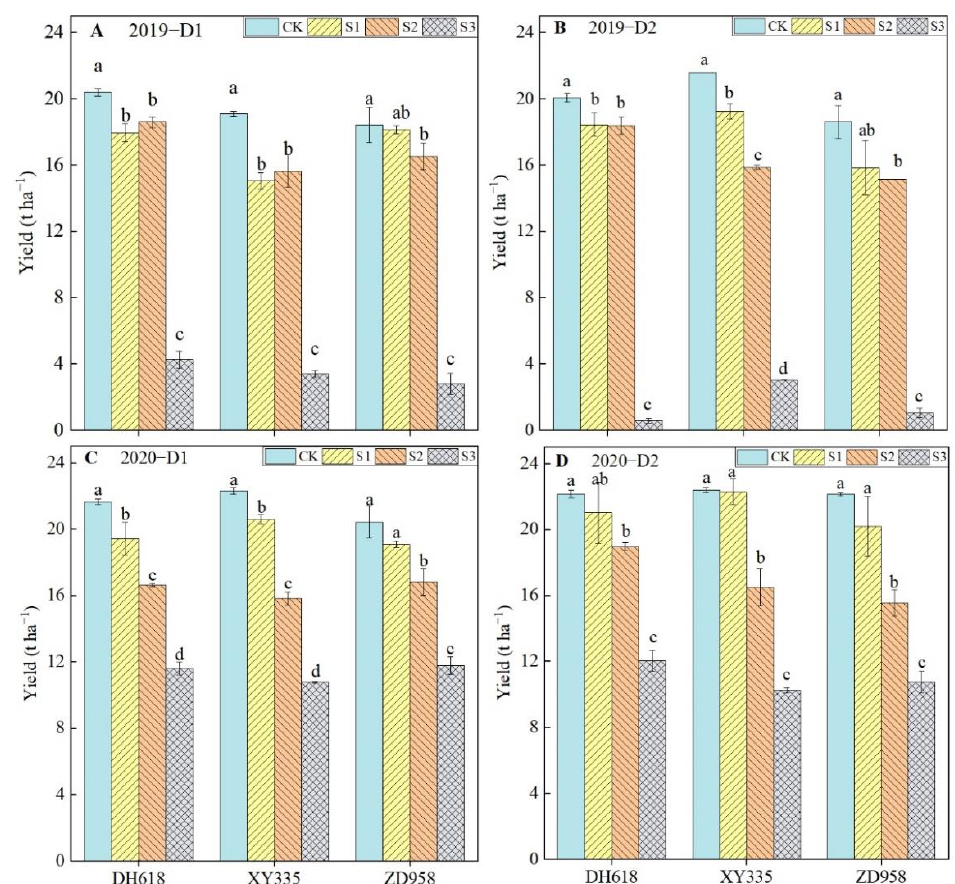
Figure 1. Effects of different shading levels (CK: 100% natural light; S1: 85% natural light; S2: 70% natural light, S3: 50% natural light) and planting densities (D1: 7.5 × 10 4 plants ha − 1 , D2: 12 × 10 4 plants ha − 1 ) on the yields of three maize cultivars: Denghai 618 (DH618), Xianyu 335 (XY335), and Zhengdan 958 (ZD958) over two years (2019 and 2020). ( A ) 2019 − D1, ( B ) 2019 − D2, ( C ) 2020 − D1, ( D ) 2020 − D2. Data are means (SD). Means with different lowercase letters are significantly different at p < 0.05.